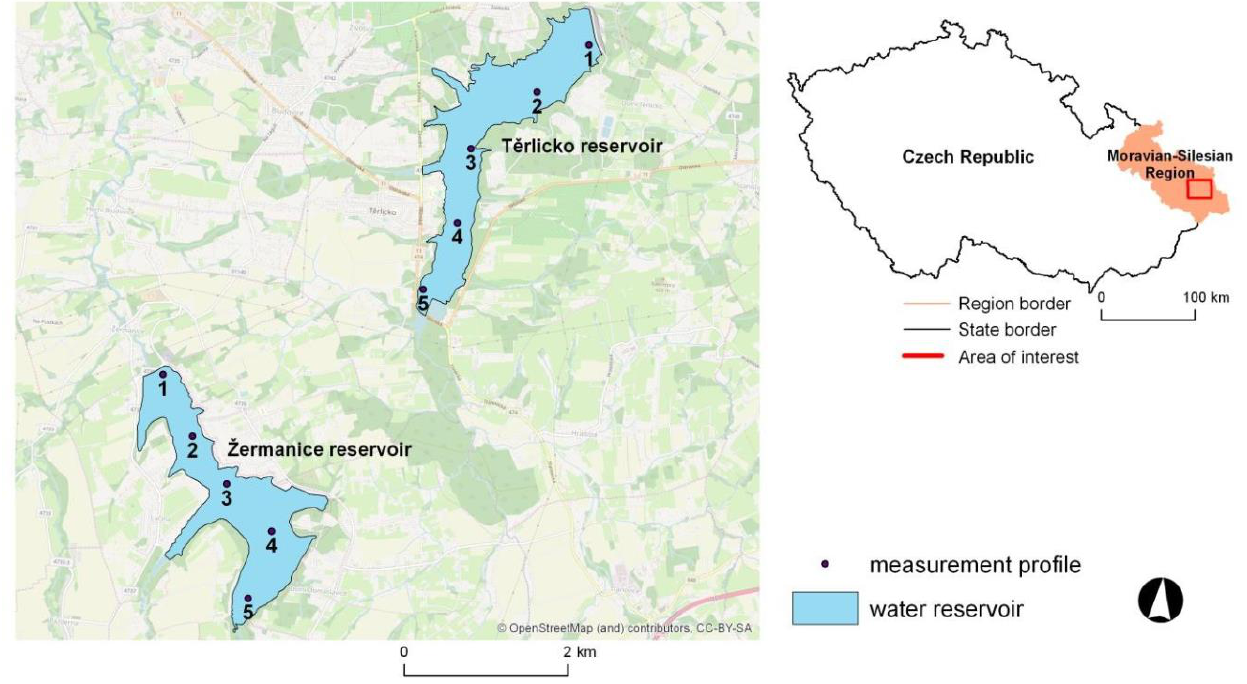
Figure 1 Measurement profile at select water